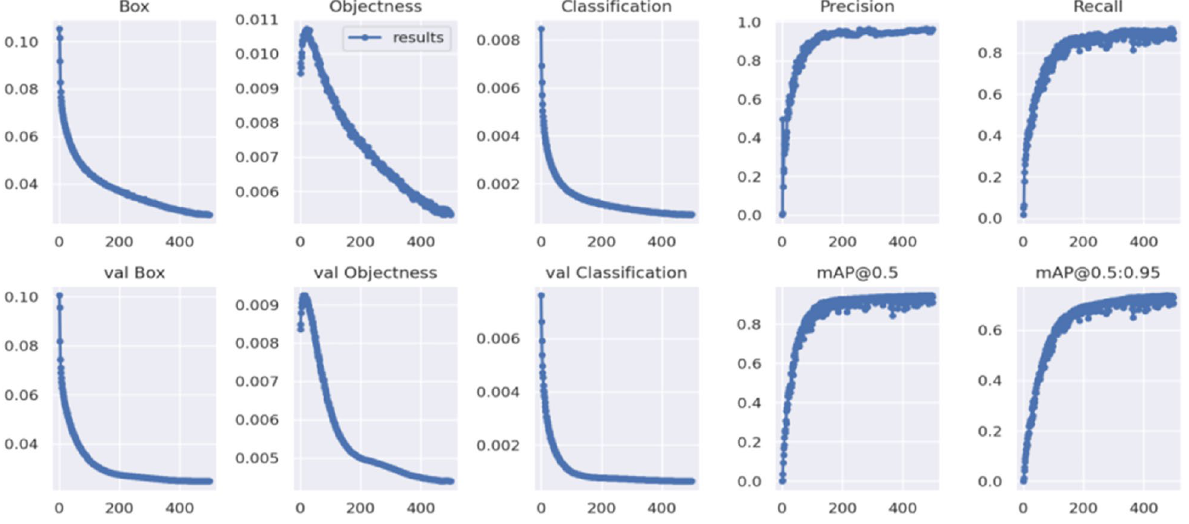
Figure 14. Result